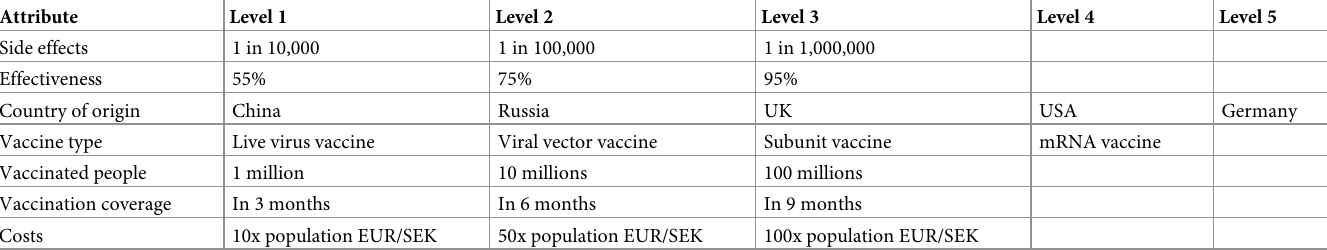
Table 1. Conjoint experimental